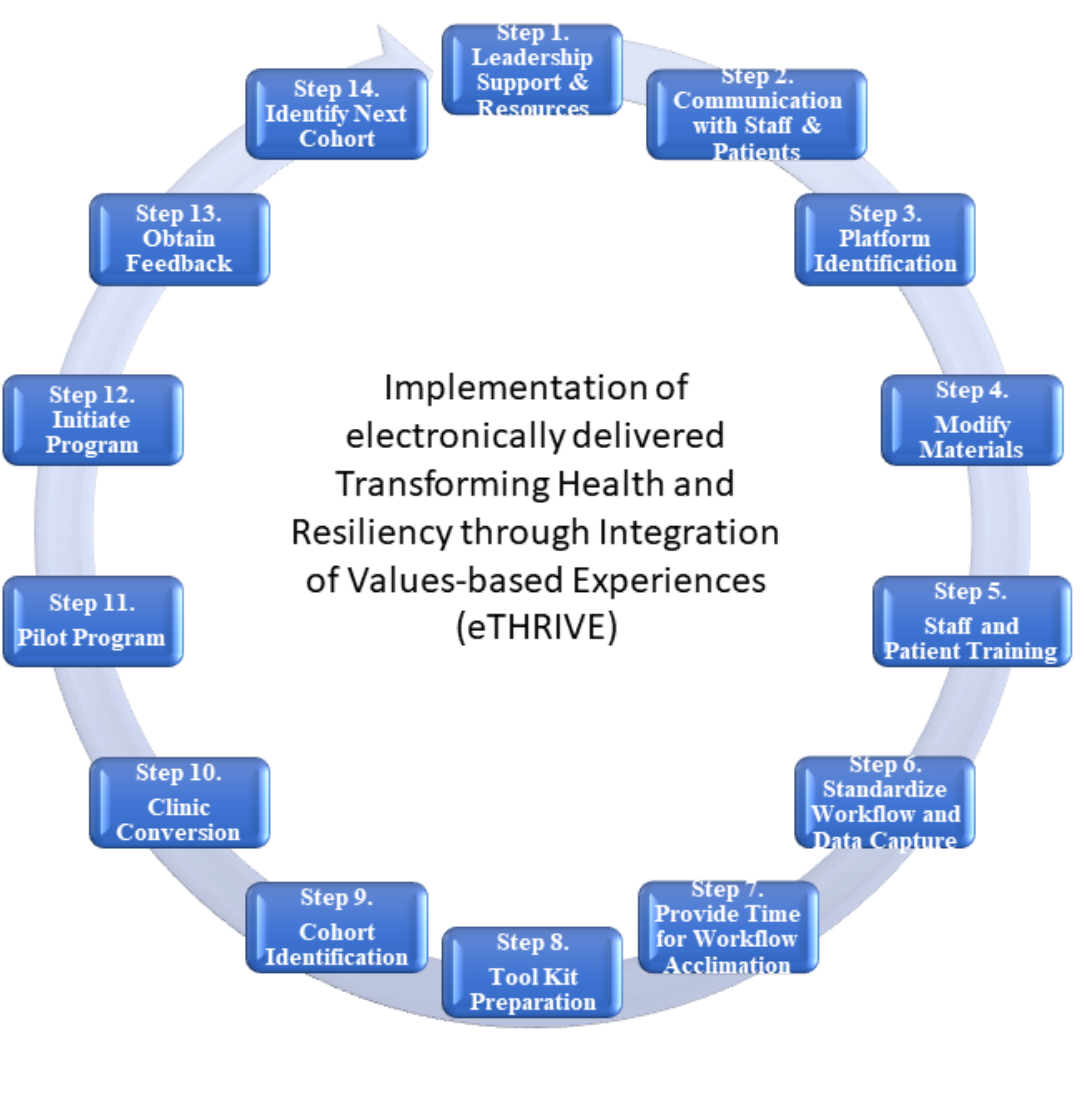
Figure 1. 14-step process for implementation of electronically delivered Transforming Health and Resiliency through Integration of Values-based Experiences